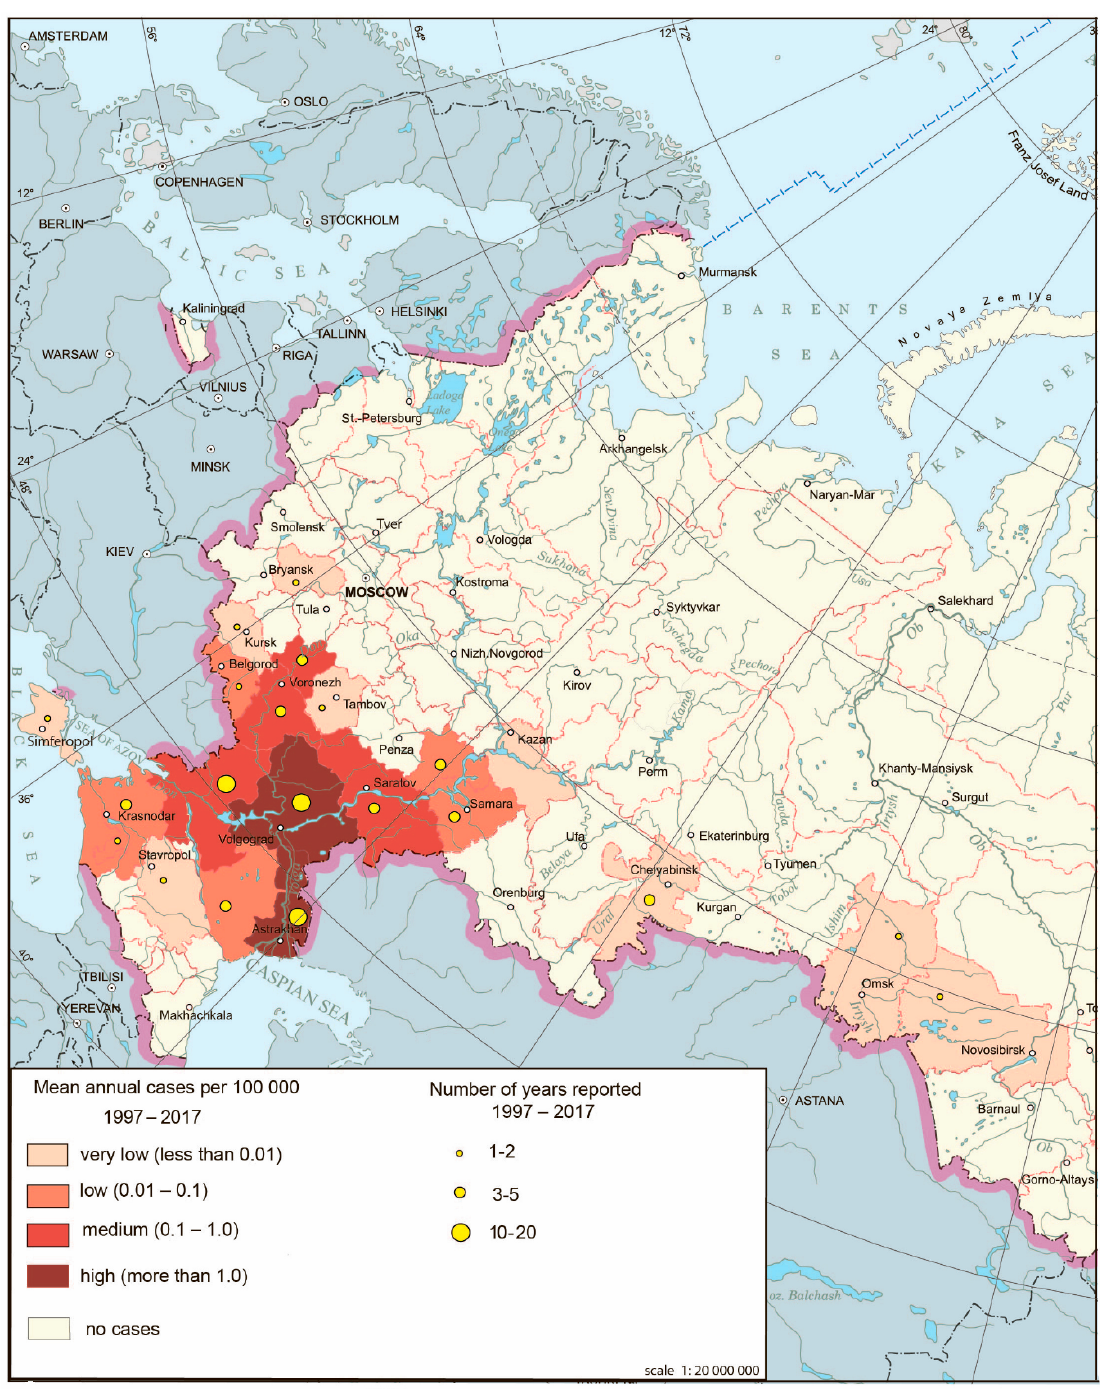
Figure 4. West Nile fever morbidity in Russia, 1997–2017.